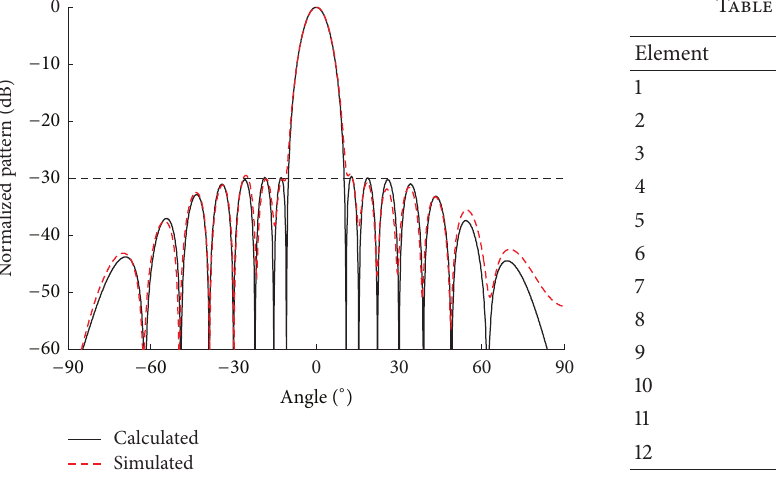
Figure 10: Radiation patterns of the resonant array.